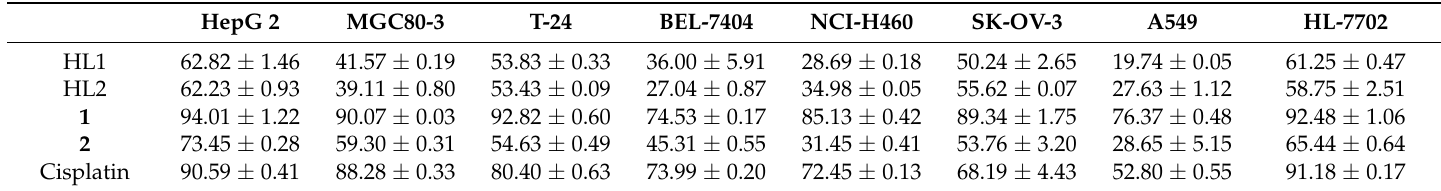
Table 7. Growth inhibition of HL1, HL2, 1 and 2 against different cell lines in vitro.